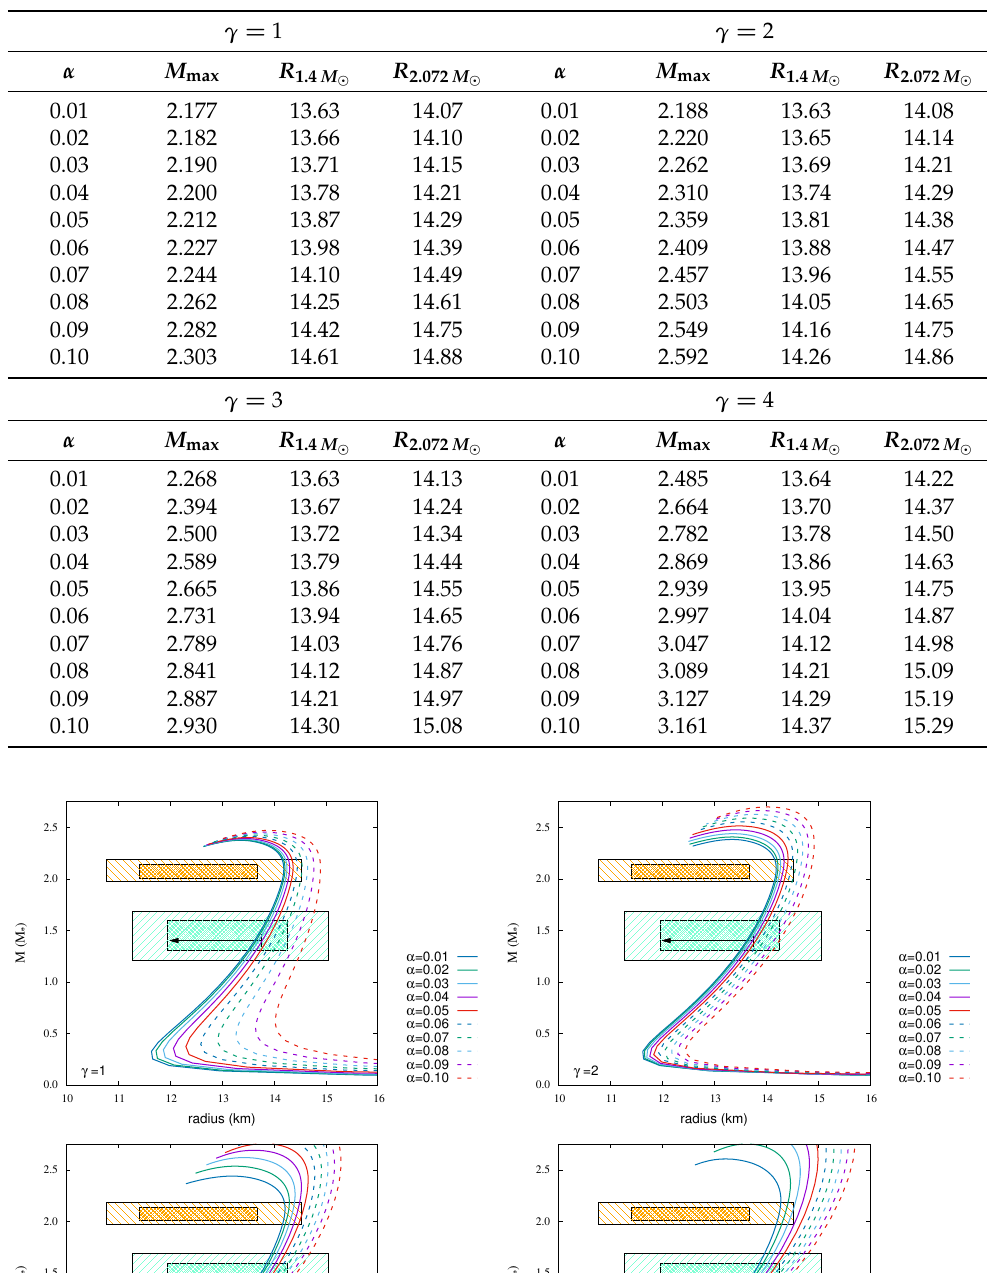
Table 7. Maximum mass ( M max ) in unit of M (cid:12) and radius (km) at M = 1.4 M (cid:12) ( R 1.4 M radius (km) at M = 2.072 M (cid:12) ( R 2.072 M B 0 = 2.5 × 10 18 G).